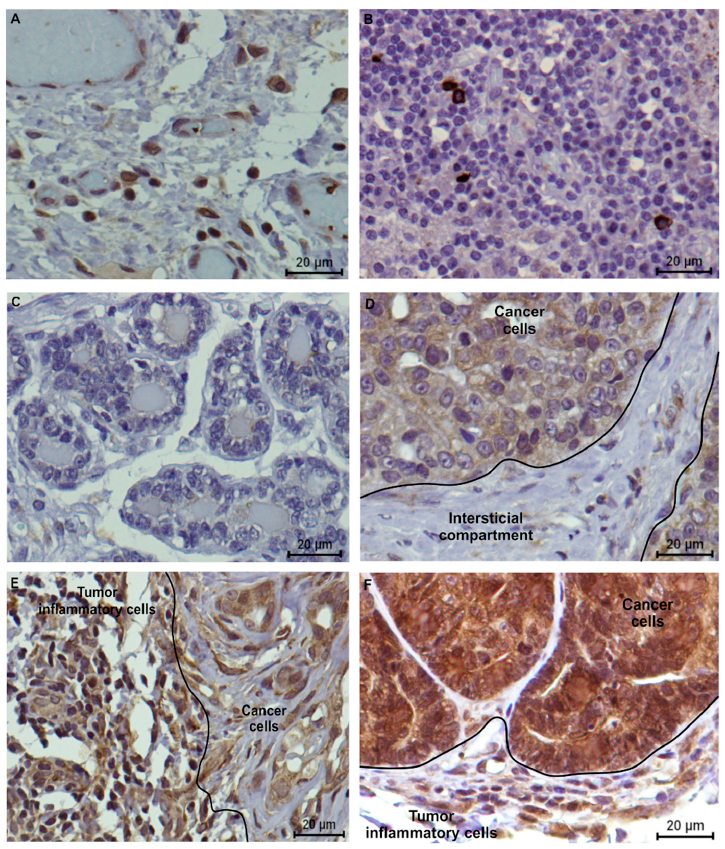
Figure 4. VISTA immunostaining in controls and feline tumor samples (400x magnification). ( A ) Human tonsil and ( B ) feline lymph nodes were used as positive controls, presenting a strong (score 3+) tissue VISTA expression in lymphocytes; ( C ) Considering the feline tumor samples, normal mammary cells and ( D ) tumor interstitial compartment revealed a negative VISTA expression. ( E ) Triple-negative (evaluated as 70% of positive TILs, with 2+ score and 60% of positive cancer cells, with 2+ score) and ( F ) HER2-positive tumor subtypes (evaluated as 80% of positive TILs, tissue expression in feline tumors.